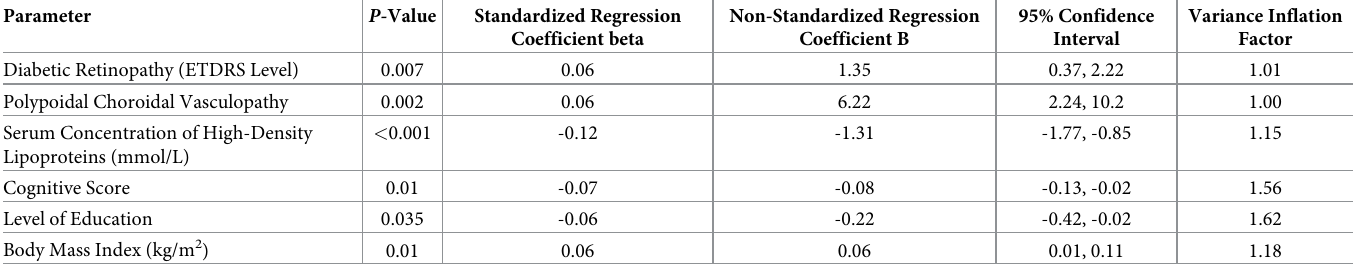
Table 2. Associations (multivariate analysis) between the serum concentration of hs-C-reactive protein and other systemic and ocular parameters in the Beijing Eye